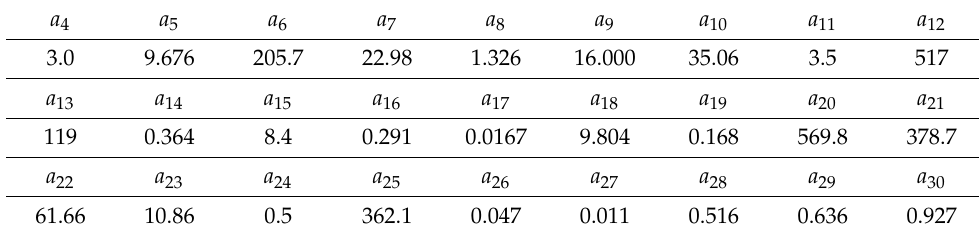
Table 7. Optimal coefficients in the phase transformation model for steel B.